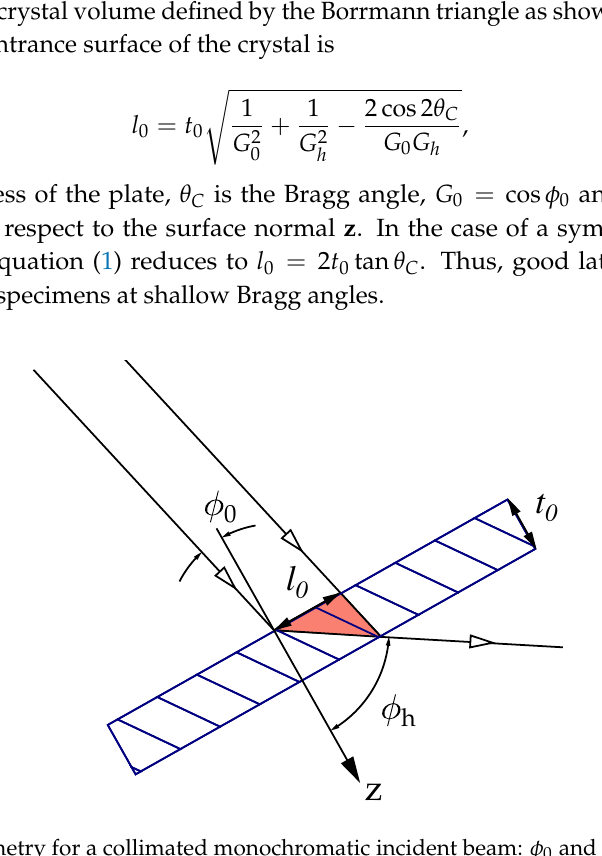
Figure 2. Laue geometry for a collimated monochromatic incident beam: φ 0 and φ h are the incidence angles with respect to the crystal surface normal z , l 0 is the base of the Borrmann triangle, and t 0 is the thickness of the crystal